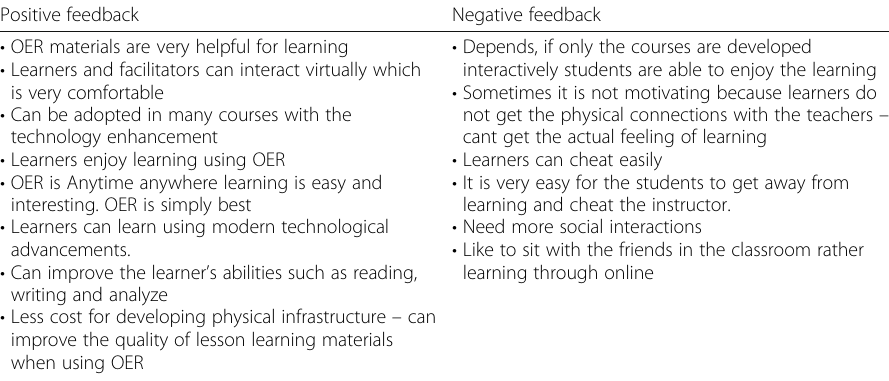
Table 3 Feedback of OER-based blended learning methods Positive feedback Negative feedback